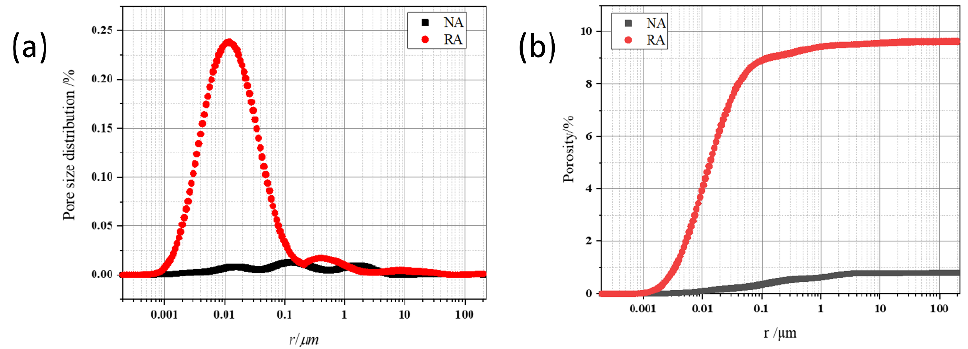
Figure 7. Pore size distribution ( a ) and cumulative porosity ( b ) of natural aggregate and recycled aggregate.